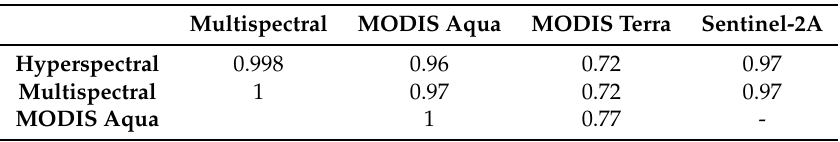
Table 2. Squared Pearson correlation coefficients of NDVI product combinations from different sensors for the forest site ‘Hohes Holz’.